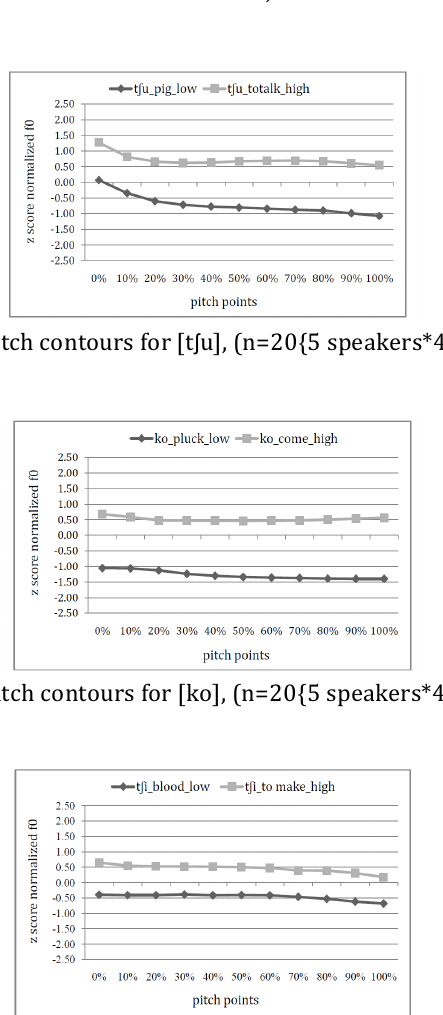
Figure 7: Normalized pitch contours for [t ʃ i], (n=20{5 speakers*4 iterations each})